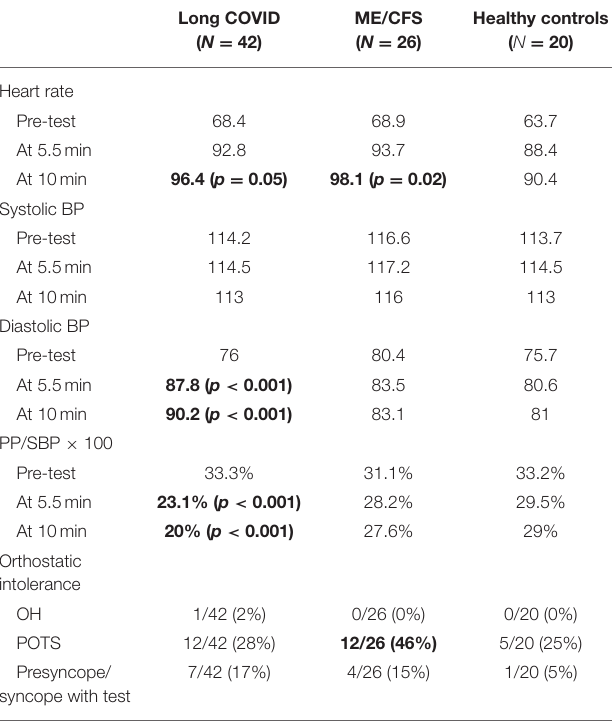
TABLE 2 | Hemodynamic measurements in each of the three groups at three time points of the NASA Lean Test, and percentage of people meeting orthostatic intolerance